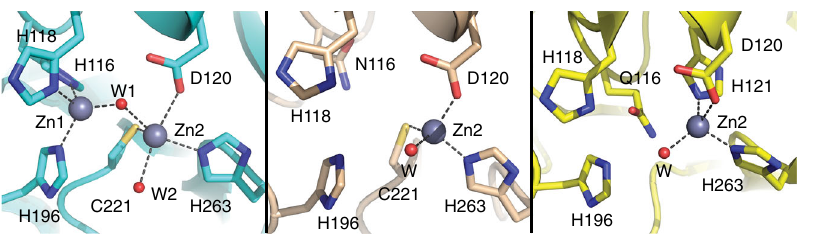
Fig. 1 Active sites of metallo- β -lactamases. Klebsiella pneumoniae bi-Zn(II)-NDM-1 (B1, PDB 3spu, left ), Serratia fonticola mono-Zn(II)-Sfh-I (B2, PDB 3sd9, center ) and E. meningoseptica mono-Zn(II)-GOB-18 (B3, model based on PDB 5k0w, right ). Zinc atoms are shown as grey spheres , and water molecules (W) are shown as small red spheres . Coordination bonds are indicated with dashed